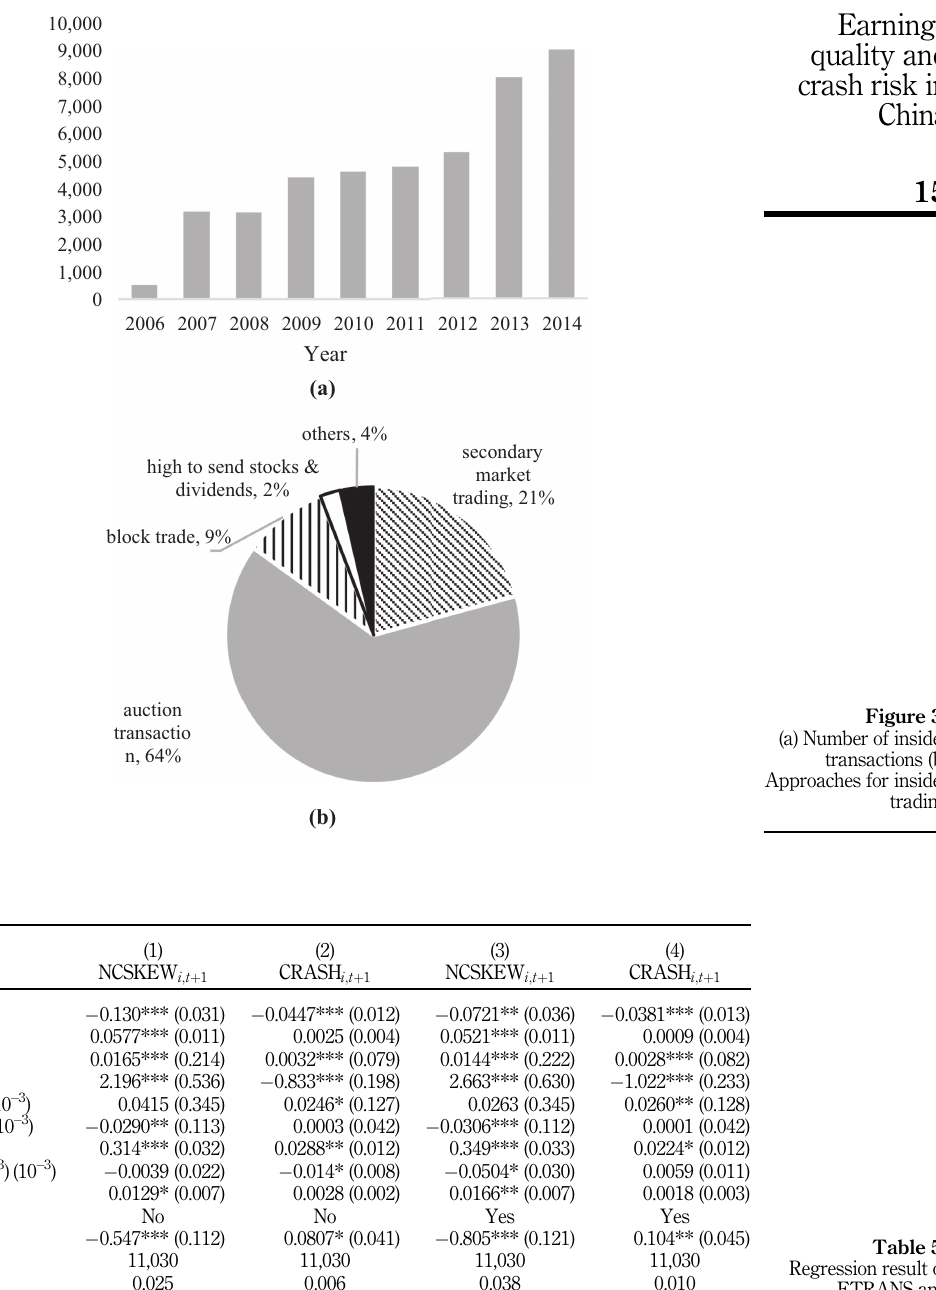
Table 5. Regression result of ETRANS and